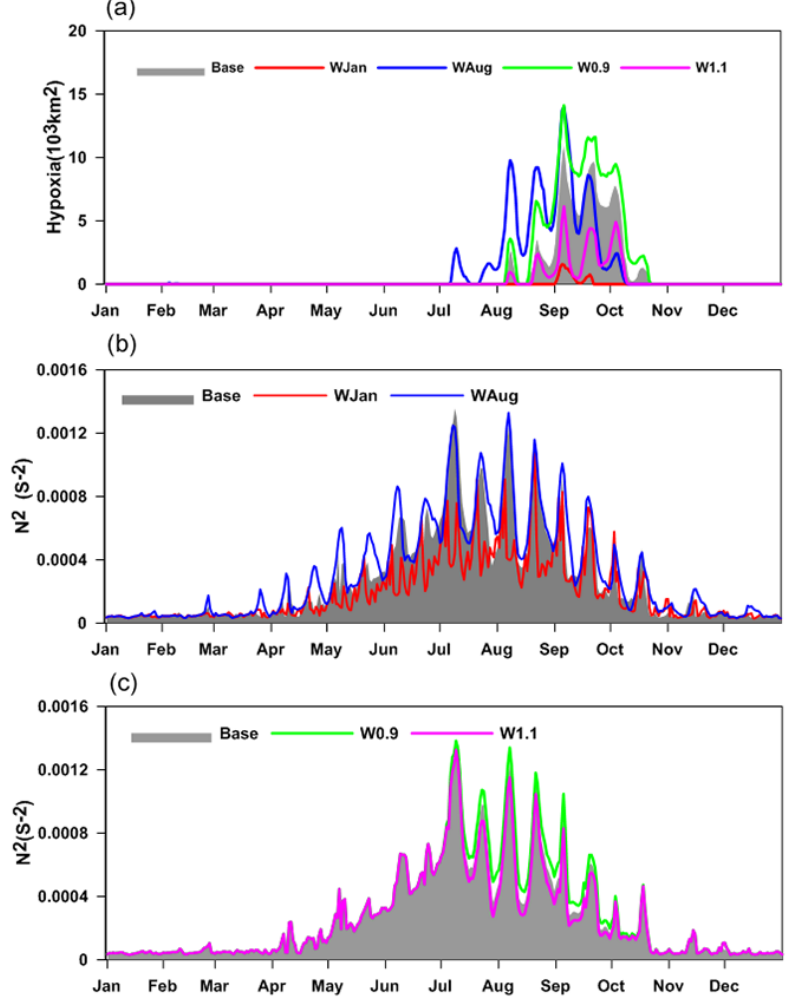
Figure 10. (a) The comparison of the simulated hypoxic area (DO<2mgL − 1 ) on the wind variation runs. (b, c) Averaged stratification N 2 for the base run (gray shadow) and wind variation runs.